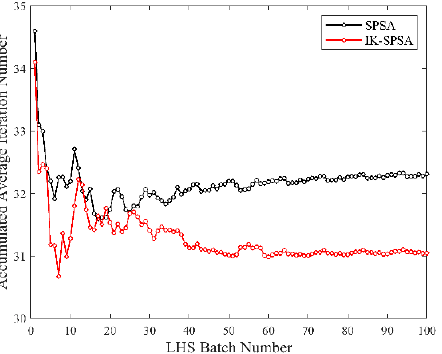
Figure 21. Accumulated average iteration number distribution at the same initial point.